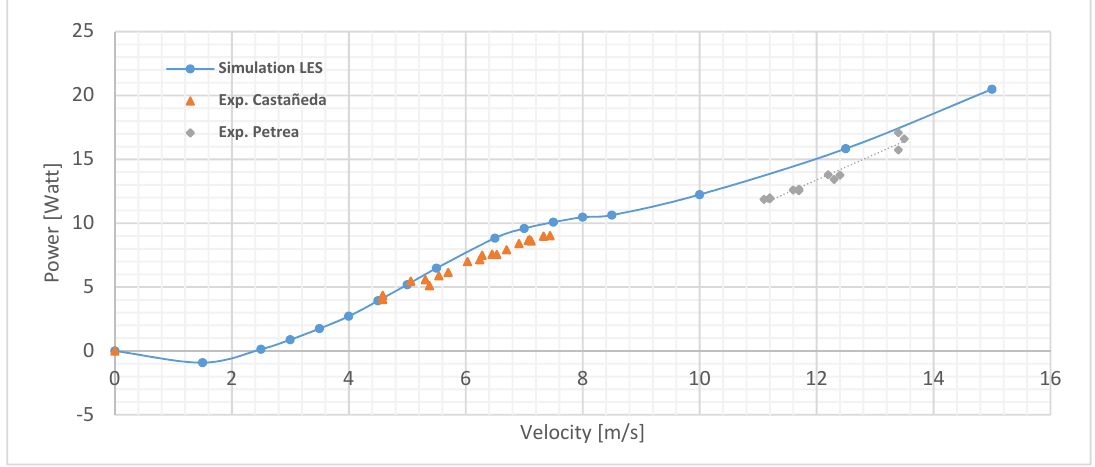
Figure 19. Power Vs Free stream velocity for Machiguá rotor seed. Pitch angle 15°. . Figure 19. Power vs Free stream velocity for Machigu á rotor seed. Pitch angle 15 ◦